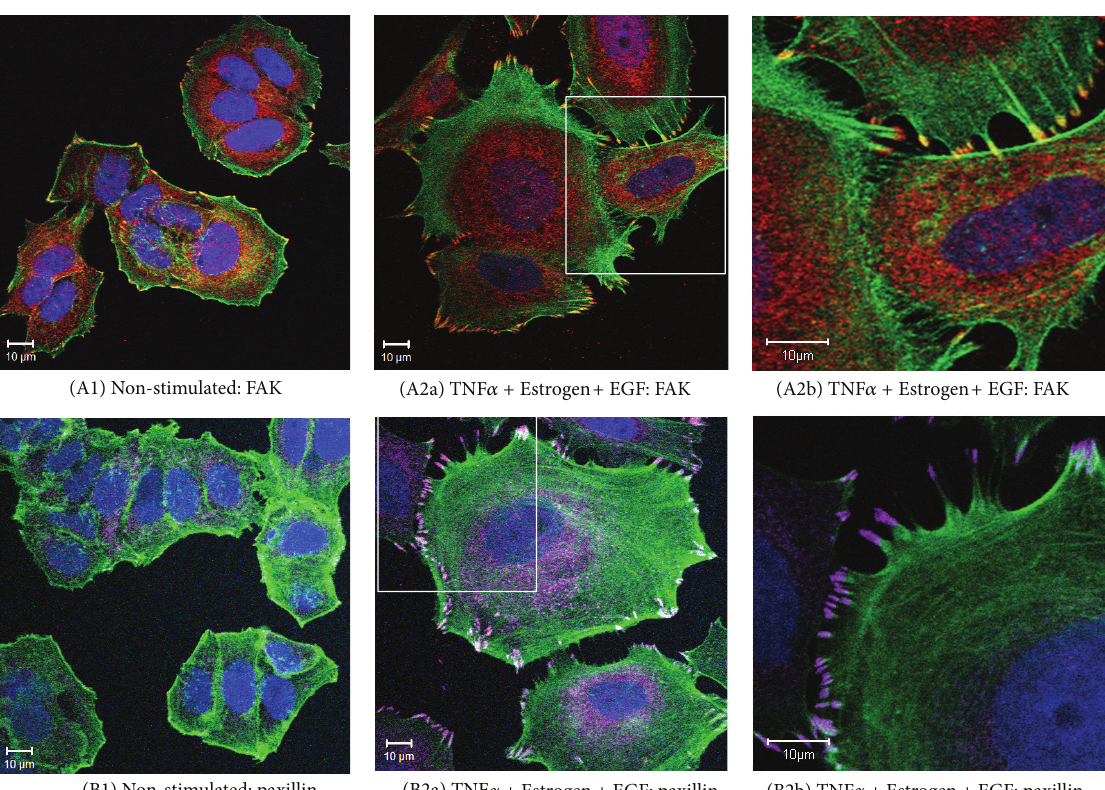
Figure 2: Combined stimulation of breast tumor cells by TNF 𝛼 + Estrogen + EGF induces the localization of FAK and paxillin in cell protrusions and formation of intertumor connecting tubes. Breast tumor cells were stimulated by TNF 𝛼 + Estrogen + EGF (concentrations as in Figure 1) for three days. Non-stimulated: cells grown with the diluents of the above factors. (A) The expression of FAK. (A1) Non-stimulated cells. ((A2a), (A2b)) Cells stimulated by TNF 𝛼 + Estrogen + EGF, where part (A2b) demonstrates the formation of tubes connecting between different tumor cells. FAK expression was detected by specific Abs (red), actin filaments by phalloidin staining (green), and cell nuclei by DAPI staining (blue). In all panels, the results are from a representative experiment of 𝑛 ≥ 3 . (B) The expression of paxillin. (B1) Non-stimulated cells. ((B2a), (B2b)) Cells stimulated by TNF 𝛼 + Estrogen + EGF, where part (B2b) demonstrates the formation of tubes connecting between different tumor cells. Paxillin expression was detected by specific Abs (purple), actin filaments by phalloidin staining (green), and cell nuclei by DAPI staining (blue). In all panels, the results are from a representative experiment of 𝑛 ≥ 3